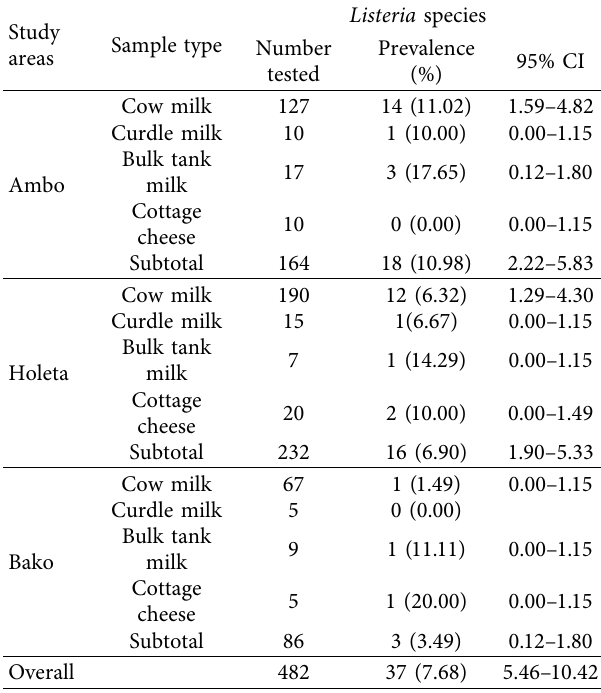
Table 1: The overall prevalence of Listeria species isolated from dairy, cow milk, and milk products in our study